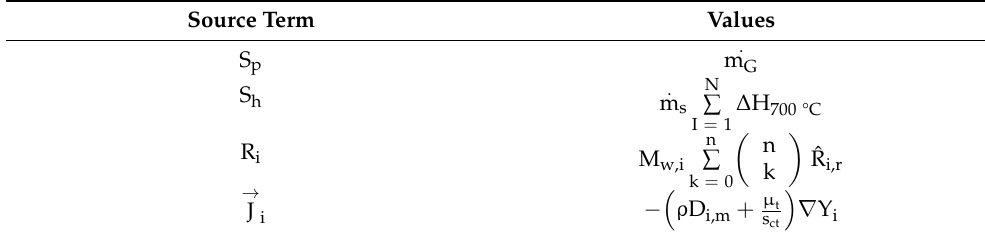
Table 4. Source term in the governing